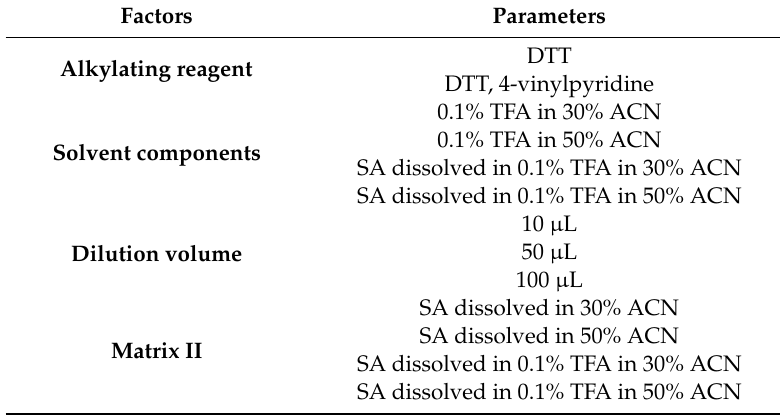
Figure 1. Effects of four major factors on matrix-assisted laser desorption/ionization time-of-flight mass spectrometry (MALDI-TOF-MS) resolution of Chinese Spring using MALDI-TOF-MS. ( A ) treatment with alkylation reagent in glutenin extraction, ( B ) solvent components, ( C ) dilution volume, and ( D ) matrix II components. Parameters shown in red were found to be optimal and were incorporated into the new method. Table 1. Major factors influencing resolution of high-molecular-weight glutenin subunits (HMW-GS) by MALDI-TOF-MS.